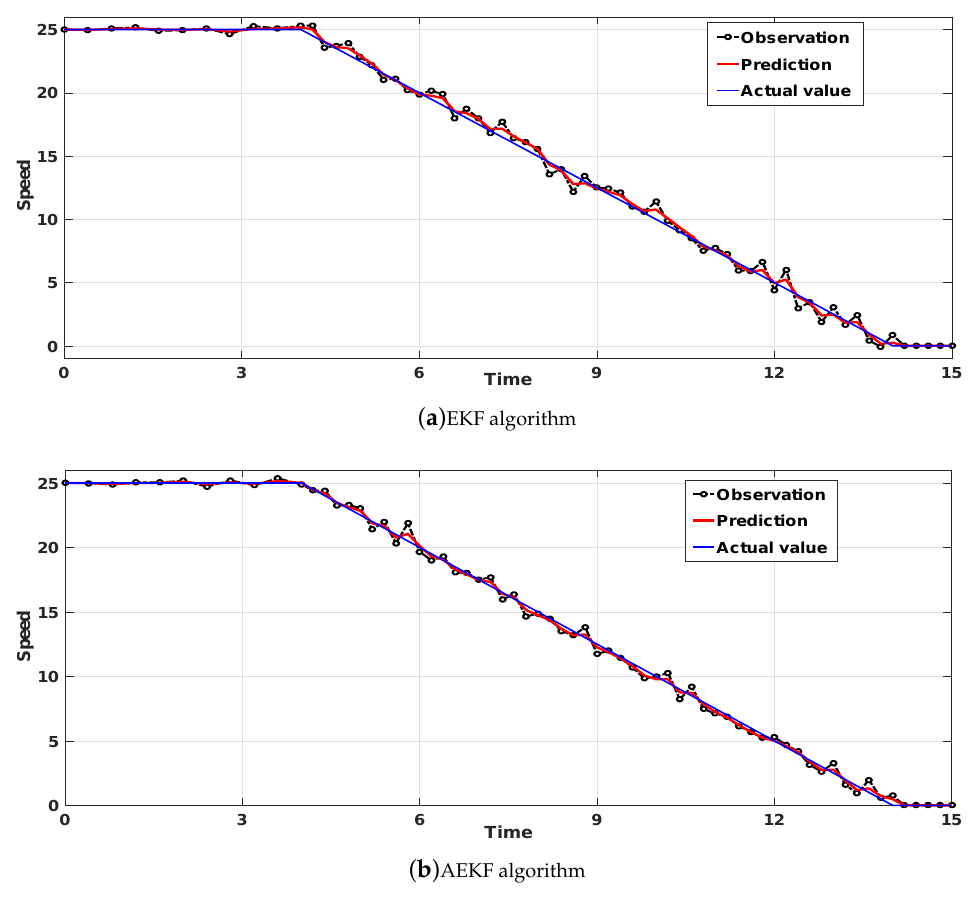
Figure 8. Speed prediction effect in the deceleration model. Table 3. Algorithmic errors in the vehicle speed